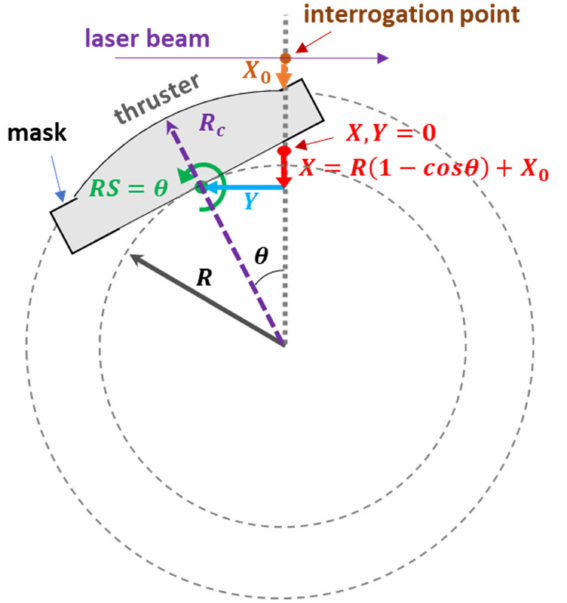
Figure 3. Diagram of thruster positioning relative to the fixed laser beam interrogation point, using rotation of the thruster and translation along X and Y axes to keep the laser tangent with a constant separation distance for each measurement location. R a is not